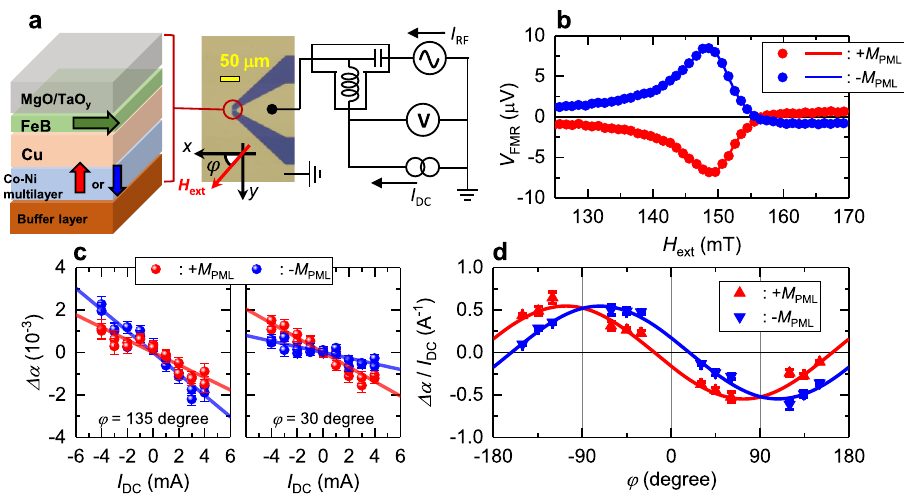
Fig. 2 Trilayer-based structure and spin-torque ferromagnetic resonance. a Schematic of multilayer stacks (left) and setup of ST-FMR measurement (right). b Resonance spectra of + M PML and − M PML states (red and blue data, respectively). μ 0 is vacuum permeability. Solid curves show fi tting curve using Eq. (3). c Dependence of modulated Gilbert damping coef fi cient Δ α on applied bias current I DC under + M PML (red) and − M PML states (blue). Left and right graphs show measurement under φ = 135° and 30°, respectively. Solid lines show linear fi tting results. d Angular dependence of damping modulation ef fi ciency Δα / I DC and ± M PML state (red and blue data, respectively). Solid curves show fi tting results using Eq.